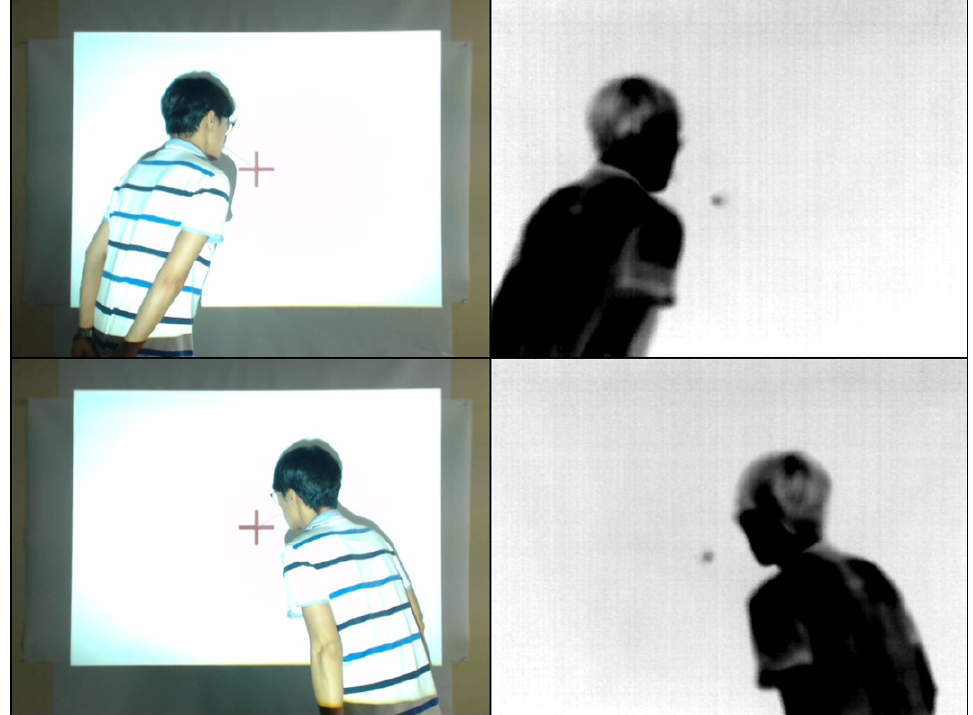
Figure 3. A scene of exhalation using a hollow rod and the resulting thermal image of a conductive hot spot. If you exhale over the cross mark, it will show up as a black dot on the thermal image. ( Left : RGB image, right : thermal